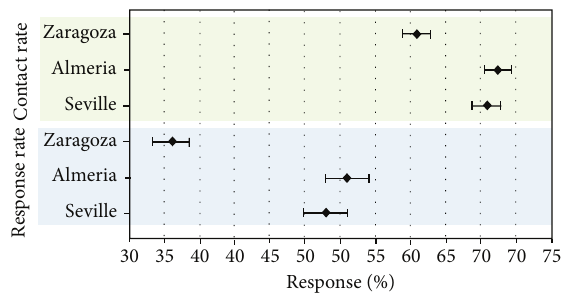
Figure 3: Contact rate and response rate by region.